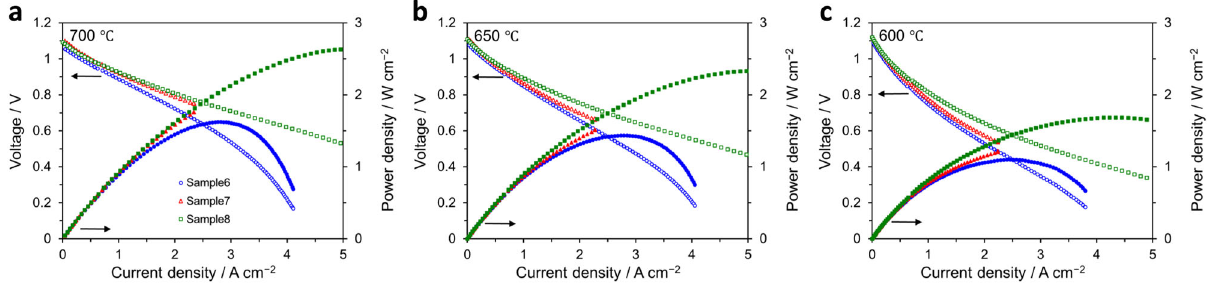
Fig. 6 Comparison of electrochemical performance of anode-supported cells. Current – voltage ( I – V ) and current – power ( I – P ) curves were evaluated at a 700 °C, b 650 °C, and c 600 °C for different anode-supported cell con fi gurations, namely Sample 6 (LSCF-GDC, blue circles), Sample 7 (LSC, red triangles), and Sample 8 (LSCF-GDC + LSC, green squares). The active electrode area was 0.785 cm 2 and the current collector was unsintered LSC paste for